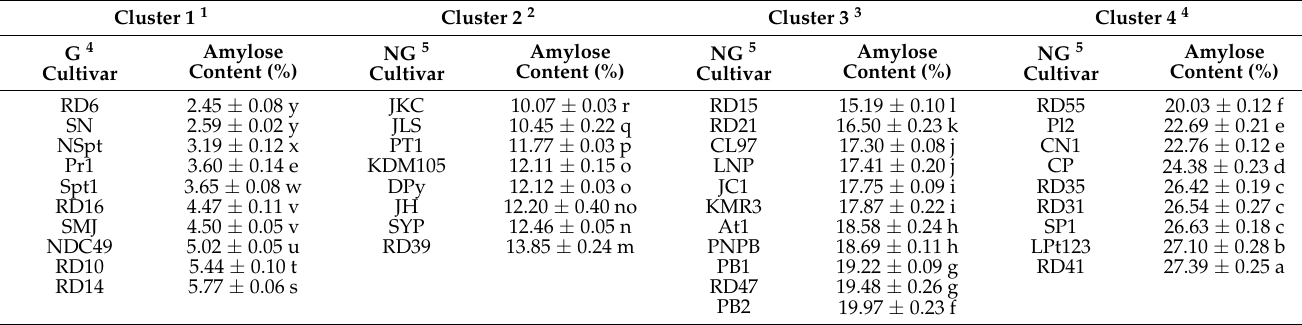
Table 4. Amylose contents in milled rice fractions of four rice cultivar